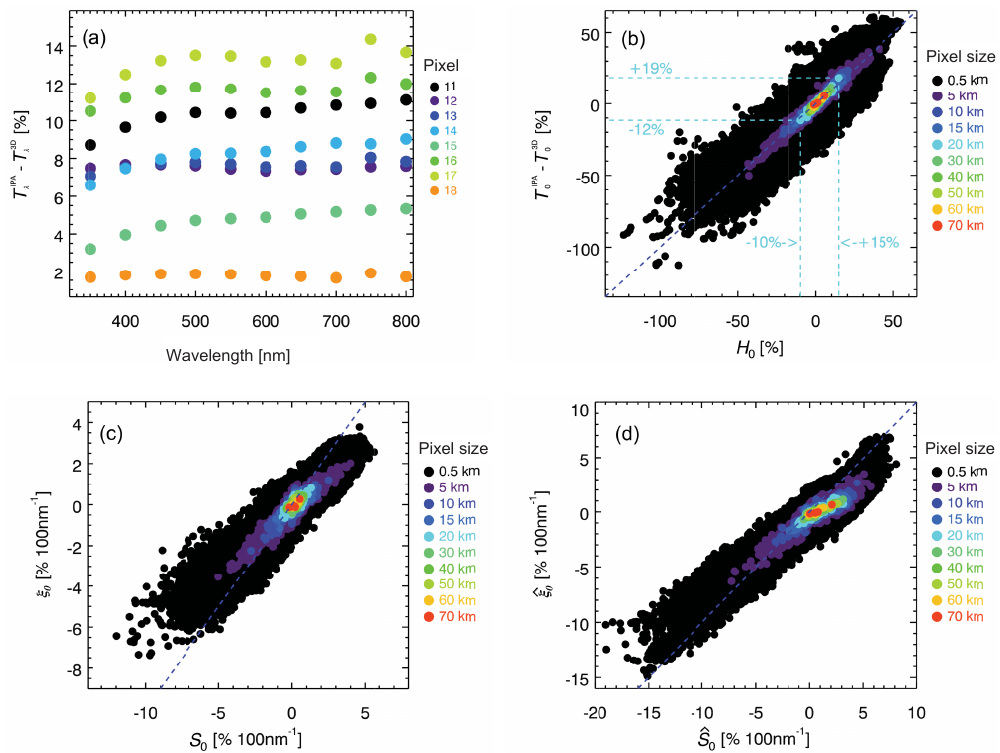
Figure 9. (a) Transmittance biases (IPA-3-D transmittance) for the eight super-pixels from Fig. 2. (b) Correlation between net horizontal photon transport from Fig. 8b and transmittance bias for multiple spatial aggregation scales. The dashed lines indicate the range of variability for 20km super-pixel size. (c) Correlation of the slopes of the quantities from (b) . (d) Same as (c) , but for a bracket from the surface to cloud top, rather than the cloud layer